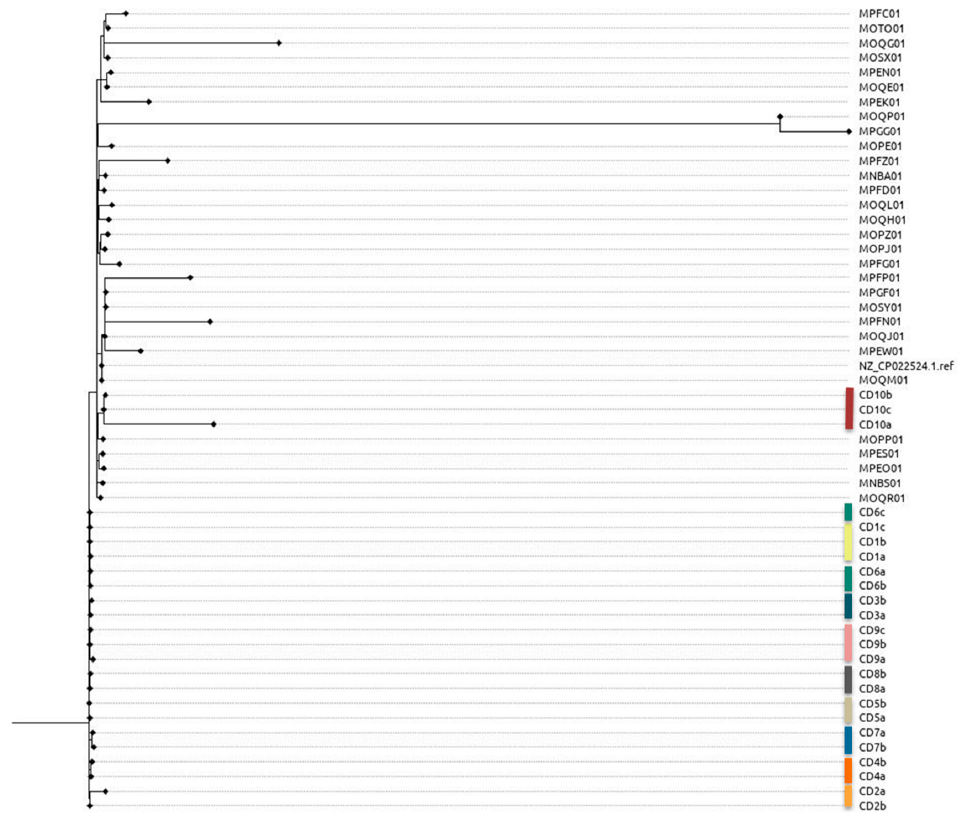
Figure 3. Maximum-likelihood core genome SNV tree showing representatives of the primary and recurrent isolates from the ten studied patients (CD1–CD10), our reference strain (LC5624; GenBank accession number: CP022524.1), and 30 US available genomes of ST-42 isolates included for comparison (ENA Bioproject number: PRJNA340238) 17 .